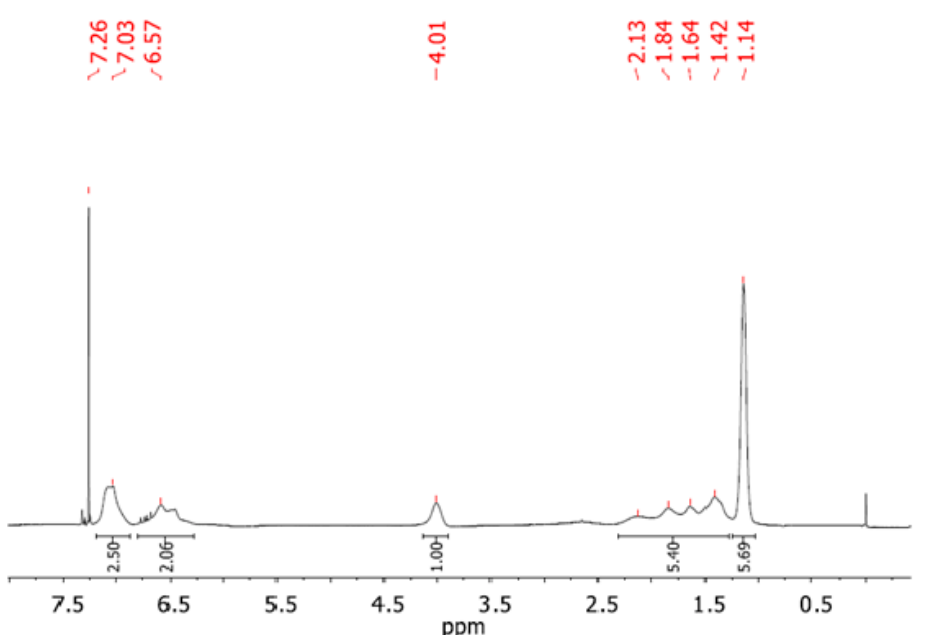
Figure 7. The 300 MHz 1 H NMR spectrum of diblock copolymer PNIPAM- b -PS (recorded for the sample denoted as PNPS2 in Table 3) in CDCl 3 .